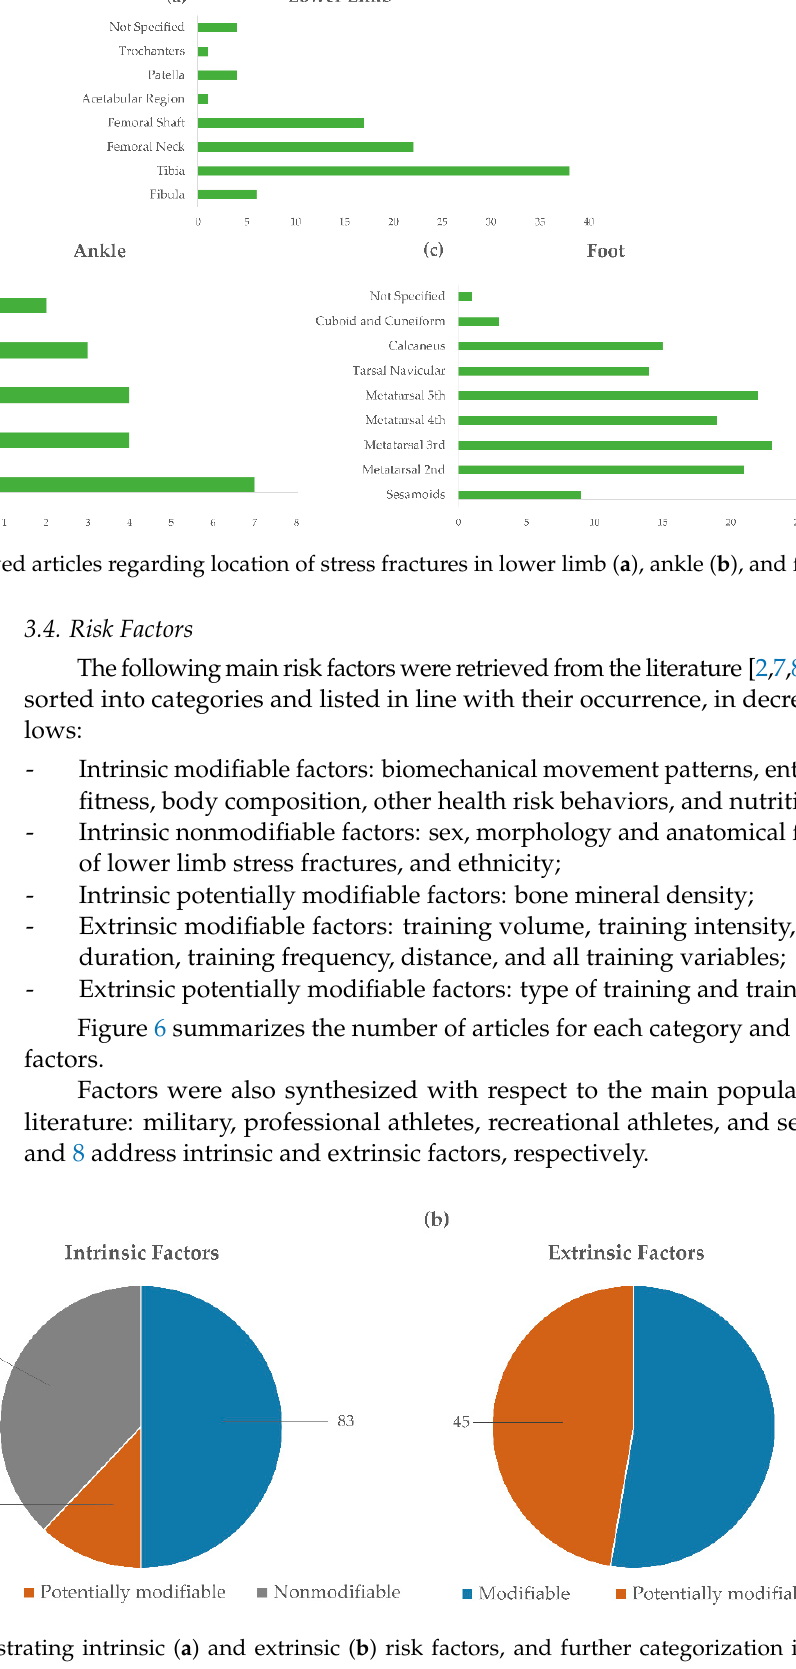
Figure 4. Reviewed articles regarding l ocation of stress fractures in the upper body ( a ) and pelvis ( b ).